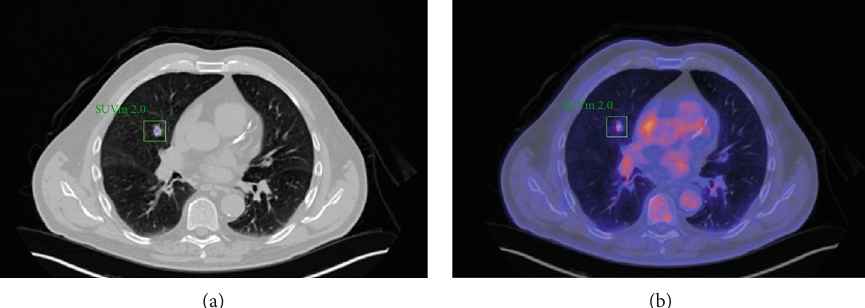
Figure 1: (a) Computed tomography image with the corresponding (b) positron emission tomography image showing 16 mm right middle lobe lung lesion (FDG avid, SUV max